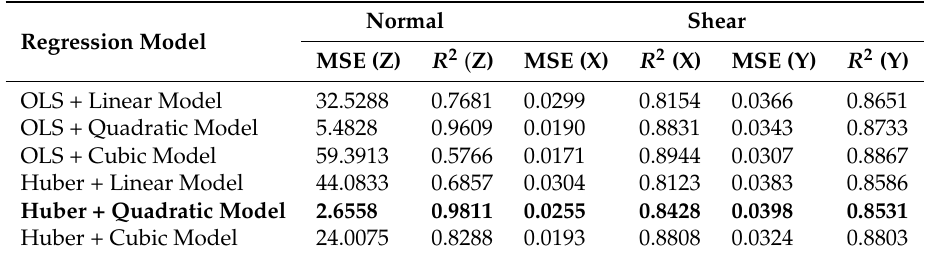
Table 1. Mean squared error (MSE) and coefficient of determination ( R 2 ) values for regression models. Normal and shear